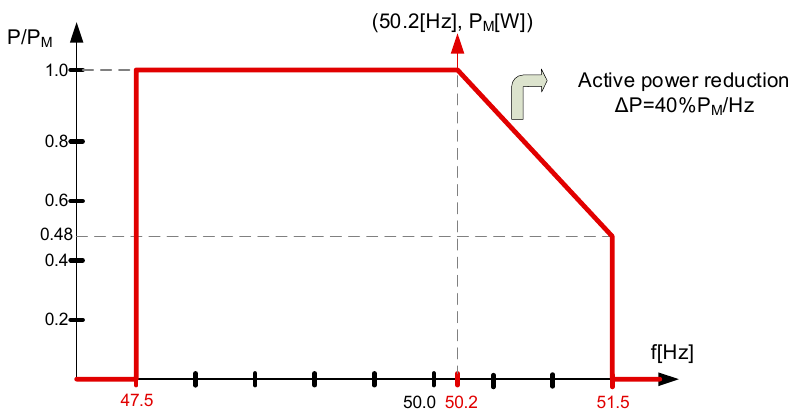
Figure 1. Standard active power frequency response characteristic P(f) applied for DER units integrated with an low voltage (LV) electrical network (based on Reference [52]).